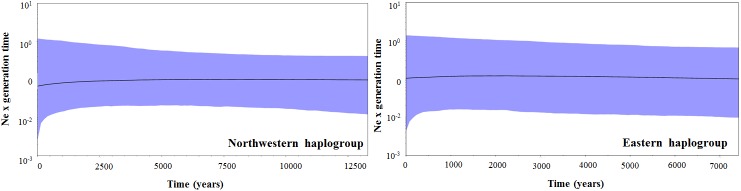
Coalescent Bayesian Skyline Plot (BSP) used to infer demographic history of P. seridoensis population groups.Black horizontal line shows median BSP estimate and blue area shows upper and lower 95% highest posterior density limits.